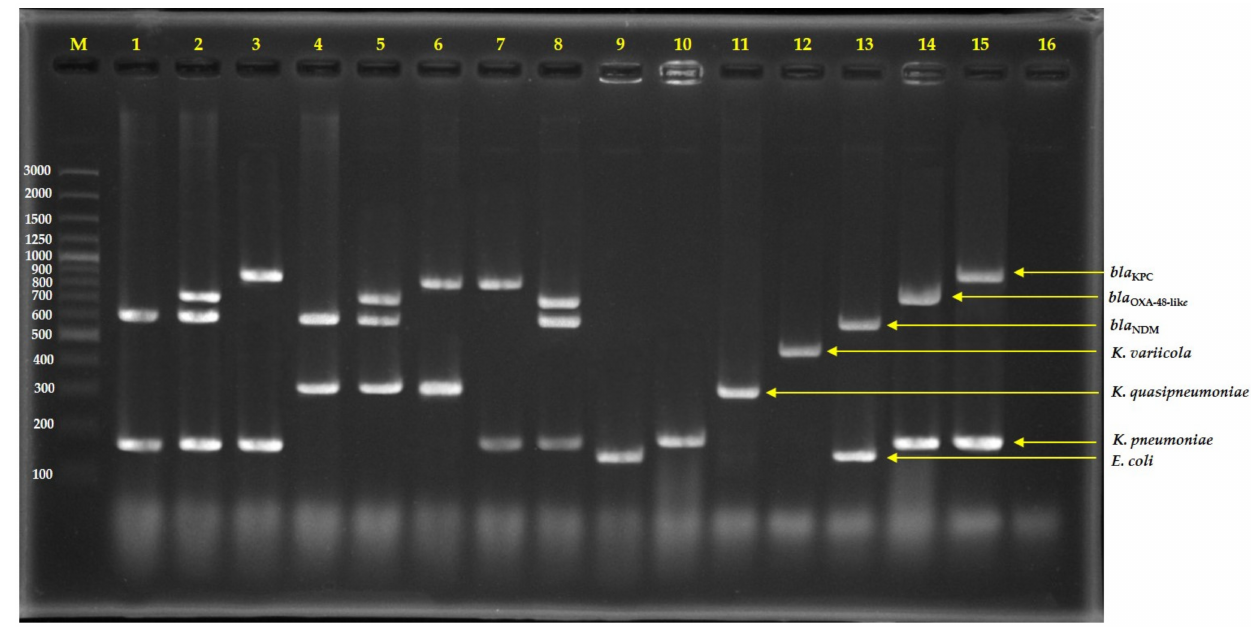
Figure 2. Agarose gel electrophoresis of multiplex PCR-amplified products from direct colonies; lane 1 = Isolate No. C76 ( E. coli with NDM), lane 2 = Isolate No. C163 ( E. coli with NDM and OXA-48-like), lane 3 = Isolate No. C1992 ( E. coli with KPC), lane 4 = Isolate No. C34 ( K. quasipneumoniae with NDM), lane 5 = Isolate No. C110 ( K. quasipneumoniae with NDM and OXA-48-like), lane 6 = Isolate No. AMR353 ( K. quasipneumoniae with KPC), lane 7 = Isolate No. C1985 ( K. pneumoniae with KPC), lane 8 = Isolate No. C73 ( K. pneumoniae with NDM and OXA-48-like), lane 9 = E. coli ATCC25922, lane 10 = K. pneumoniae ATCC27335, lane 11 = K. quasipneumoniae ATCC700603, lane 12 = K. variicola ATCC- BAA830, lane 13 = E. coli ATCC-BAA2469 (contain NDM), lane 14 = K. pneumoniae ATCC-BAA2524 (contain OXA-48), lane 15 = K. pneumoniae ATCC-BAA1705 (contain KPC), lane 16 = negative control, and lane M = 100 bp DNA